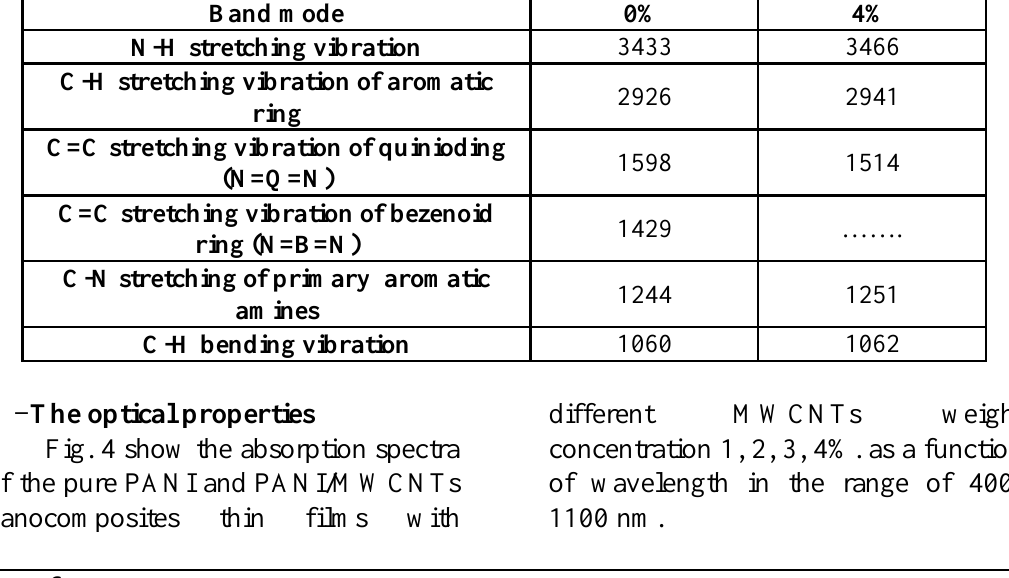
Table 1: FT-IR spectra for pure polyaniline, and PANI/MWCNTs nanocomposites thin films with MWCNTs Wight concentration 4%.